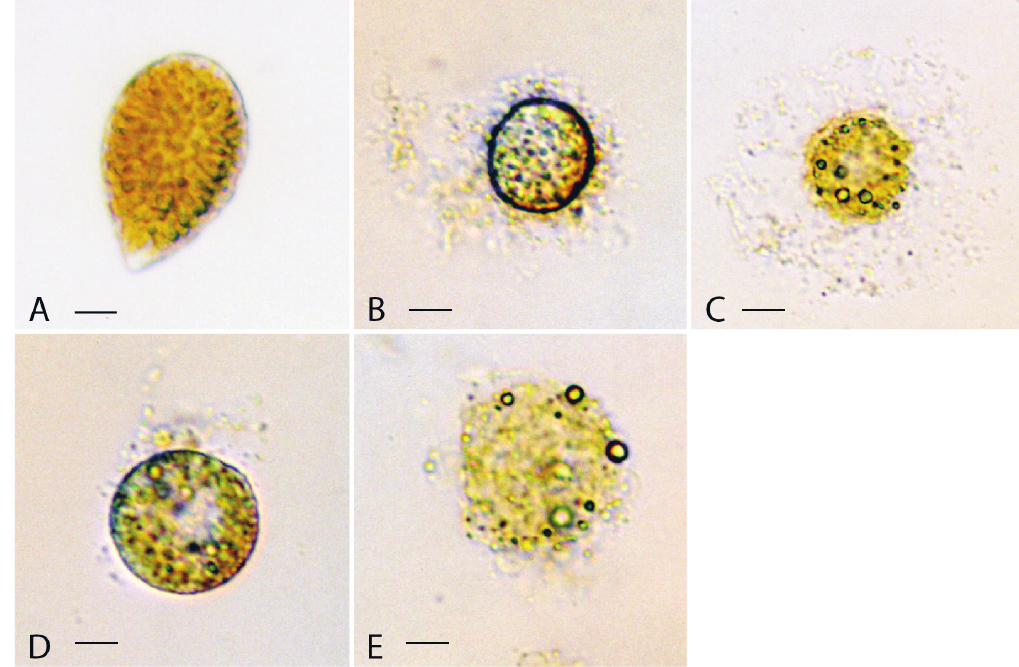
Figure 3. Light micrographs of Chattonella marina cells exposed to ( A ), methanol in the control experiment for 10 h, showing a healthy cell; ( B ), lipophilic extract of Vicicitus globosus (VgTx) for 2 min, showing large amount of cellular materials being discharged from the cell; ( C ), VgTx for 5 min, showing the collapsed cell surrounded by a cloud of cellular material; ( D ), lipophilic extract of Chattonella marina (CmTx) for c. 12 min, showing a little of cellular materials being released from the cell; ( E ), CmTx for 20 min, showing the collapse of a disintegrated cell. (scale bars from A to E = 5 μ